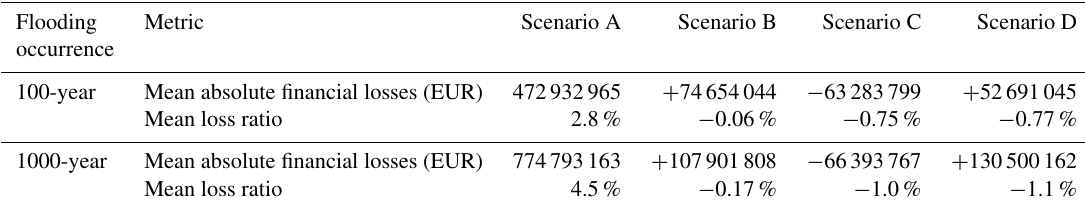
Table 3. Mean loss metrics for Scenario A, and absolute changes to these metrics in Scenarios B, C, and D. Flooding